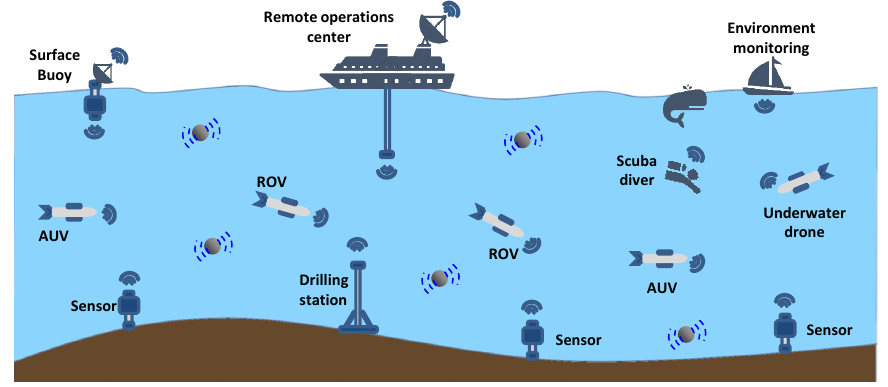
Figure 1. An underwater wireless sensor